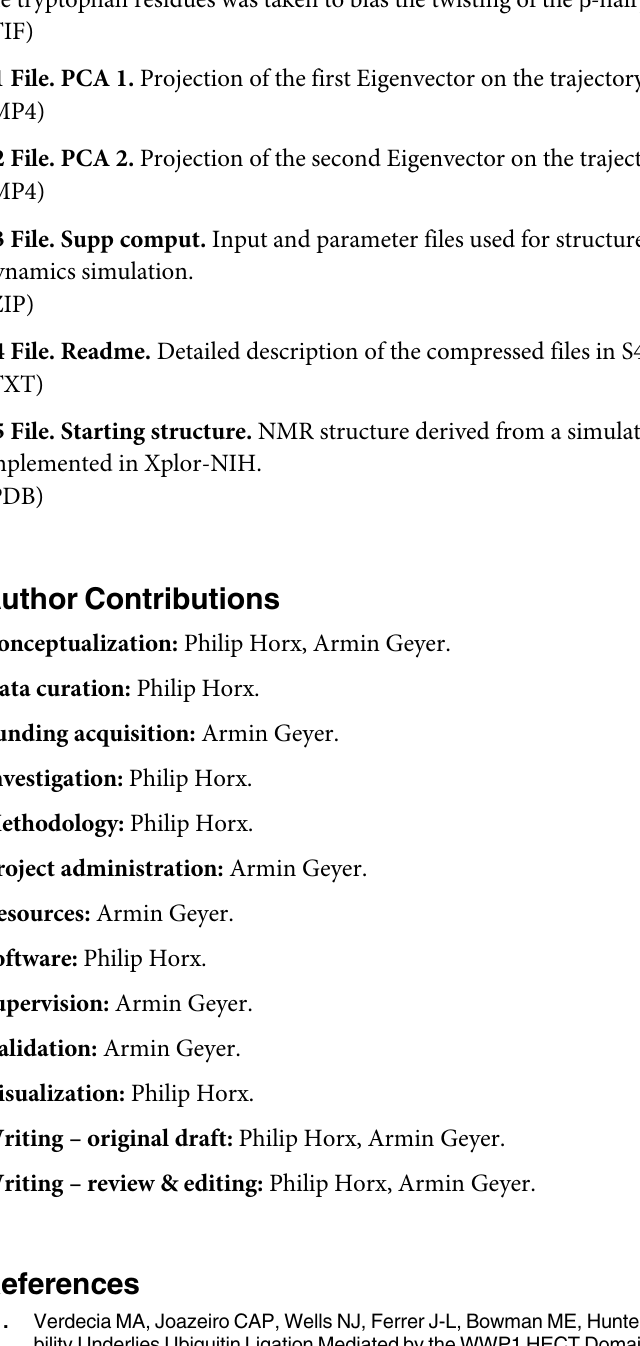
S8 Fig. Depiction of CVs used in different metadynamic simulations. The center of mass of the tryptophan residues was taken to bias the twisting of the β -hairpin motifs. (TIF) S1 File. PCA 1. Projection of the first Eigenvector on the trajectory. (MP4) S2 File. PCA 2. Projection of the second Eigenvector on the trajectory. (MP4) S3 File. Supp comput. Input and parameter files used for structure elucidation and MD/meta- dynamics simulation. (ZIP) (TXT) S5 File. Starting structure. NMR structure derived from a simulated annealing protocol implemented in